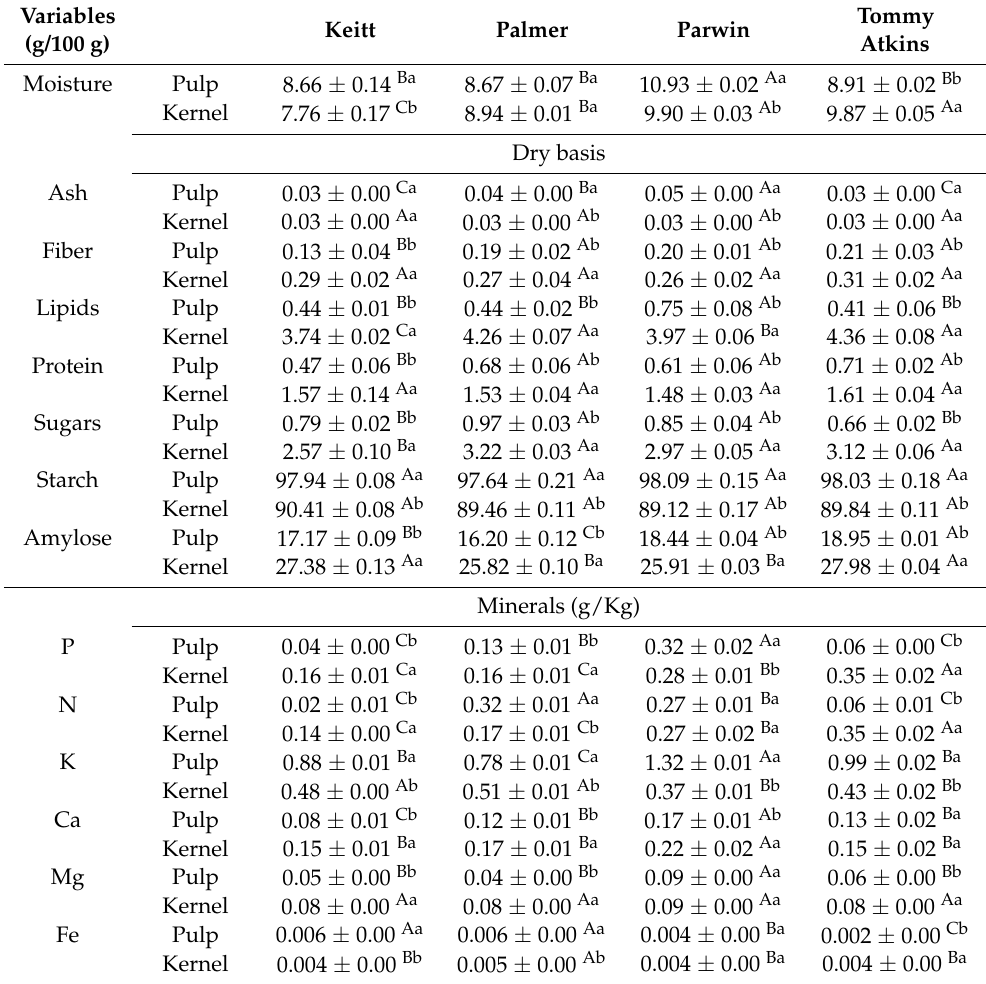
Table 1. Chemical composition of mango starches from different